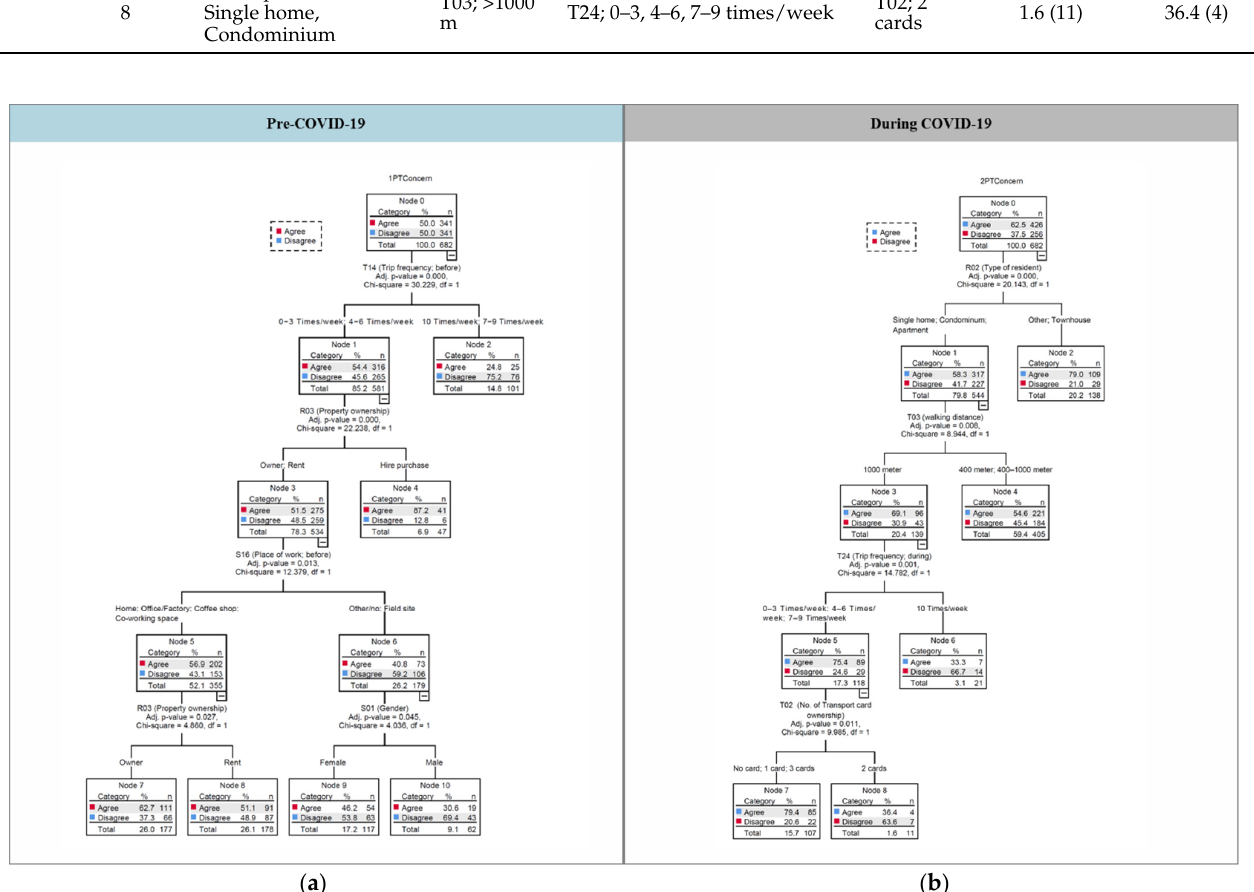
Figure 5. Decision tree map of attitude toward concern about contracting infection from use of public transport for ( a ) Pre-COVID-19 ( b ) During COVID-19.